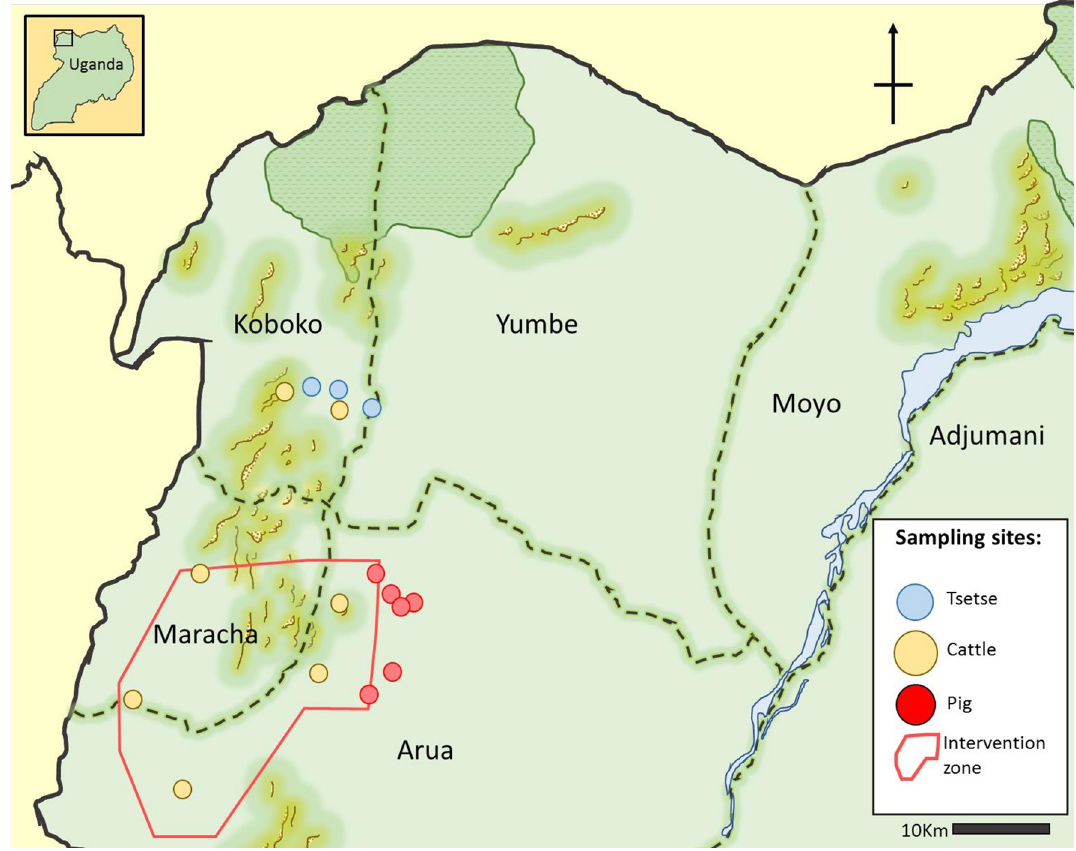
Fig 1. Map of sampling sites for tsetse, cattle and pigs from N.W. Uganda. Intervention zone denotes the area that was under tsetse control during the collection of samples described in this paper [27]. The map was created by authors for this publication using Gnu Image Manipulation Software